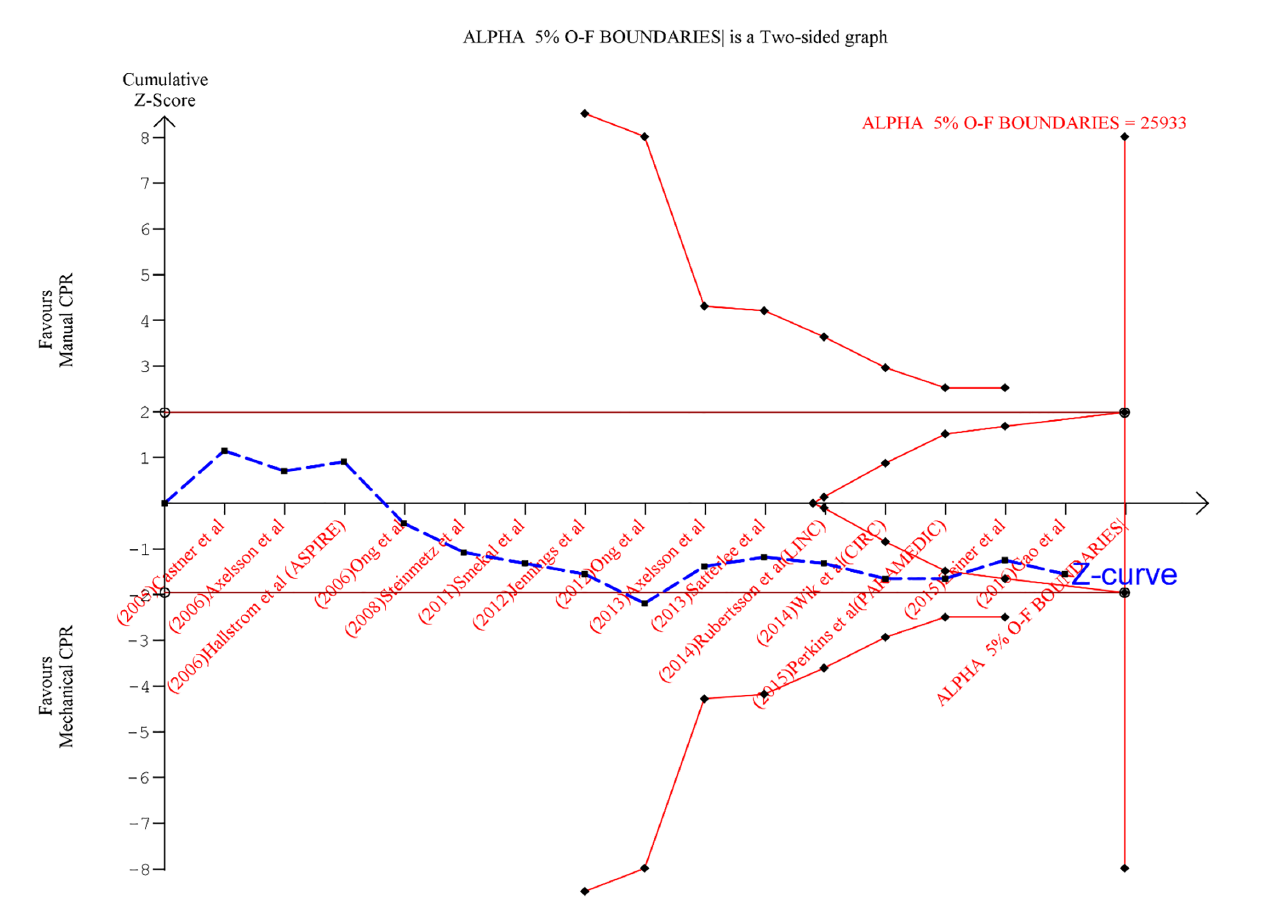
Figure 4. Trial sequential analysis for favorable return of spontaneous circulation (ROSC) outcome. The diversity-adjusted information size (sample size) equal to 25,933 (vertical red line). The cumulative Z-curve (blue line with small black squares representing each trial) failed to cross both the traditional (horizontal maroon line), trial sequential monitoring boundary (concave red line). But it crosses the futility boundary (red triangle), indicating firm evidence supporting the lack of favorable ROSC outcomes with mechanical compressions during cardiopulmonary